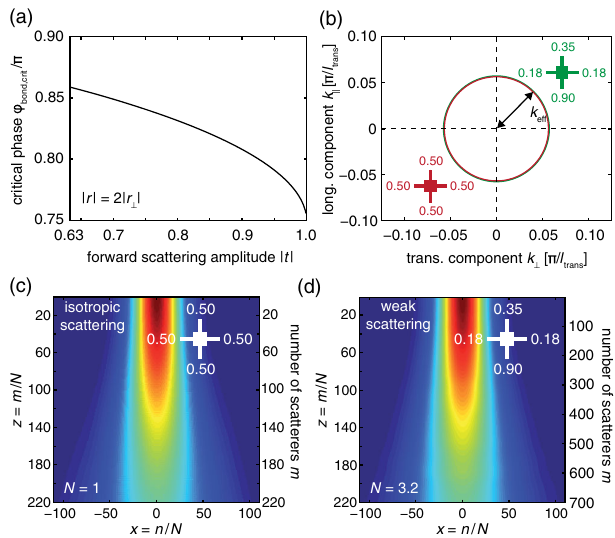
FIG. 6. Comparison between the simulation of isotropic and weak scattering. (a) Plot of the critical phase φ , for which bond ; crit the dispersion relation is pointlike, depending on the scattering amplitude in the forward direction j t j under the assumption that j r j ¼ 2 j r j . The dispersion relation is asymptotically circular for ⊥ φ ≲ φ . (b) Exemplary dispersion relations for isotropic bond bond ; crit ( j t j ¼ j r j ¼ j r ⊥ j ¼ 0 . 5 , red line) and weak ( j t j ¼ 0 . 9 , j r j ¼ 2 j r ⊥ j , green line) scattering. Depending on the exact value of φ , the bond two graphs are almost congruent in the Brillouin zone in terms of ¼ Nl the transport mean free path length l . (c),(d) Results trans scat of numerical simulations for isotropic (c) and weak (d) scattering. Weak scattering can be thought of as increasing the spatial resolution. The initial width of the Gaussian field distribution and the size of the considered region are the same in both cases in effective transverse and longitudinal distance measures x ¼ n=N and z ¼ m=N , respectively, which are the multiples of traversed transport mean free path